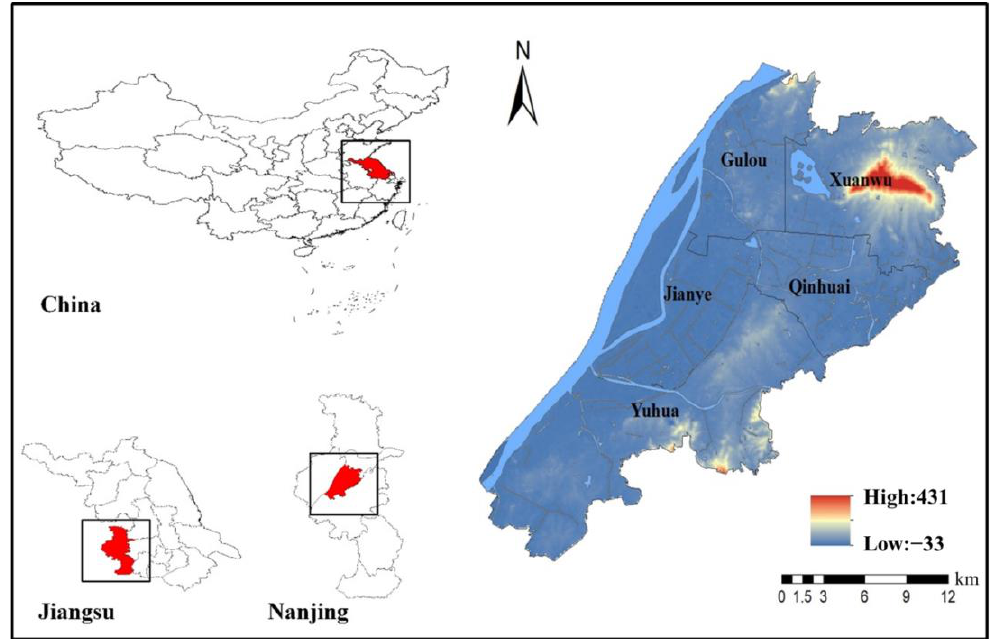
Figure 1. Administrative divisions of the research area.